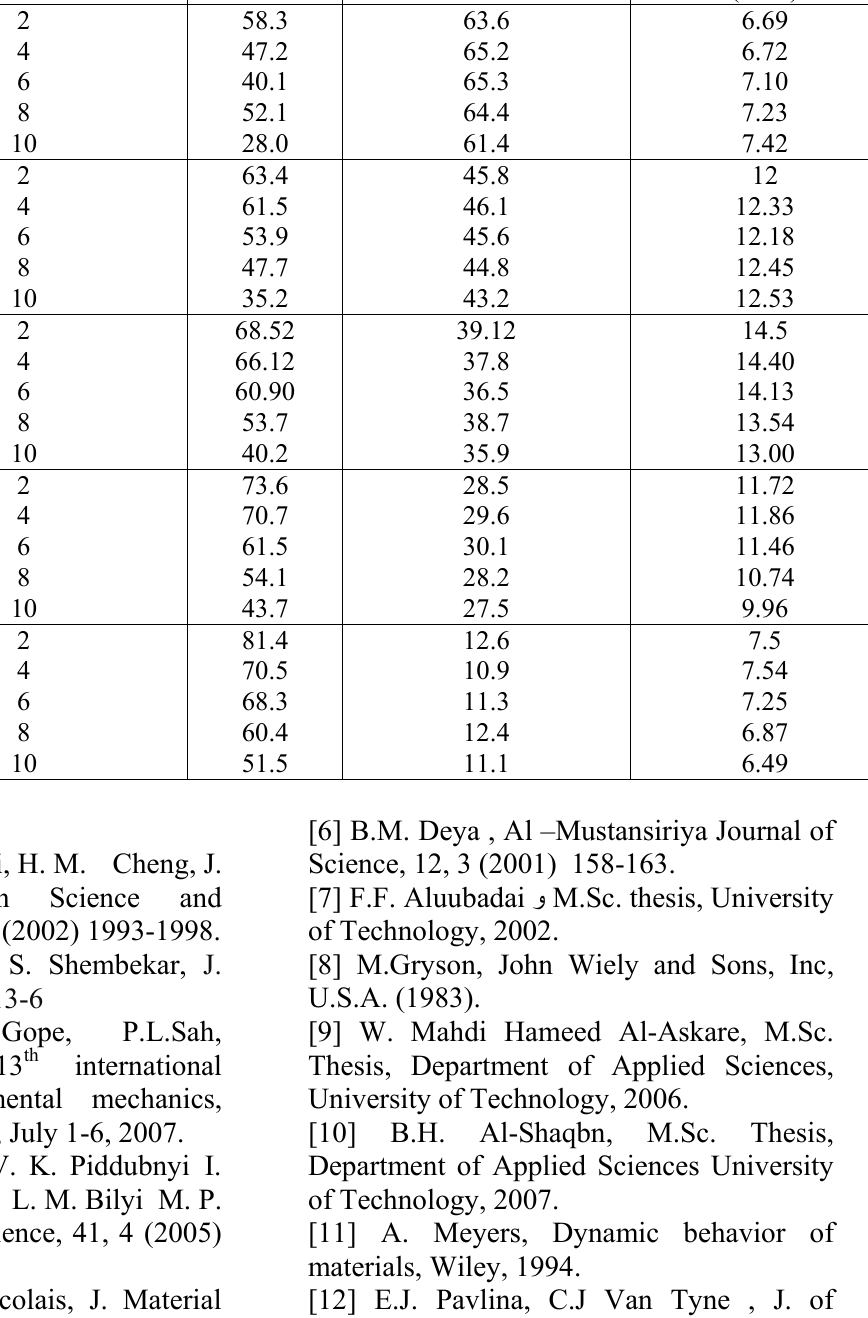
Table 1: Mechanical tests values of composite samples in different immersion periods Iron particles